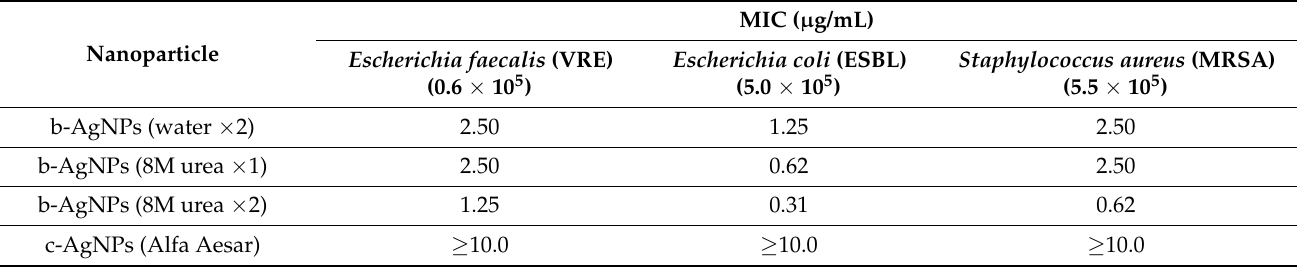
Table 3. Minimum inhibitory concentrations (MIC) of tested nanoparticles against antibiotic resistant strains of Enterococcus faecalis, Escherichia coli, and Staphylococcus aureus after 24 h incubation at 37 ◦ C in ambient